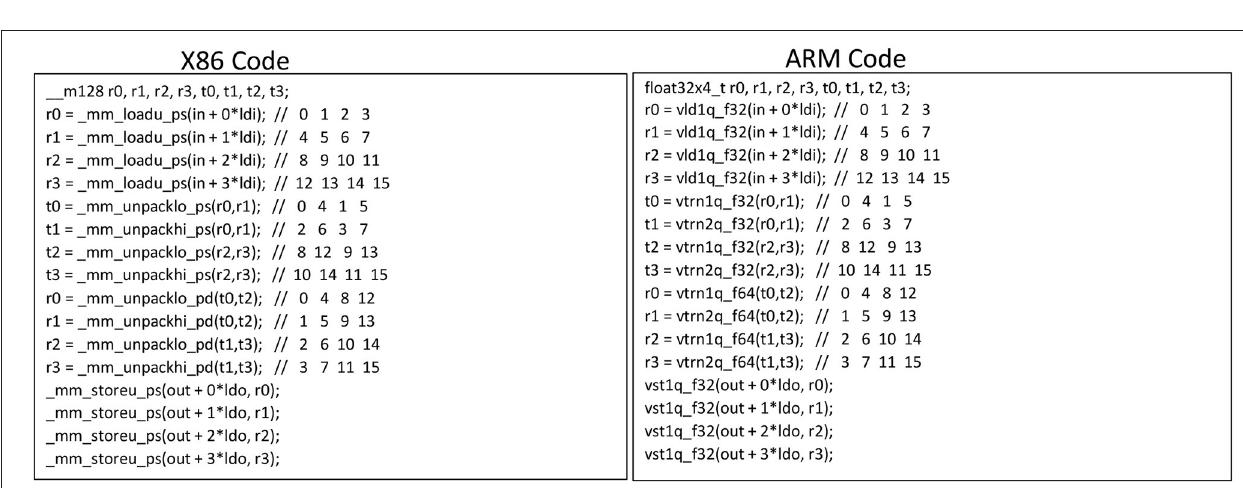
FIGURE 6 | Comparison of X86 and ARM code for a simple 4 × 4 single precision transpose using unpack instructions. The glossary contains detailed descriptions of the used intrinsic